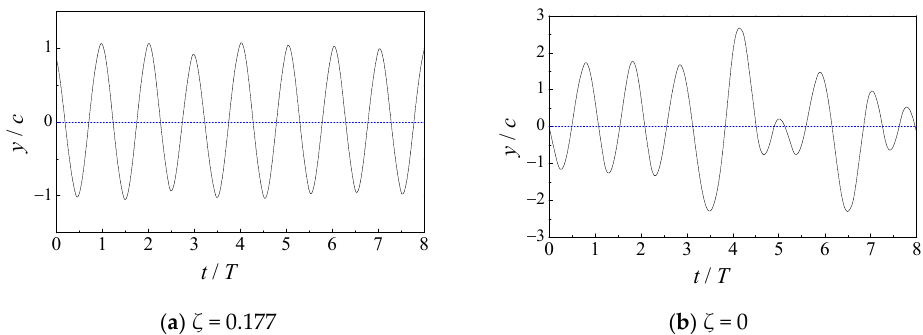
Figure 9. Heavy displacement time history curves with different damping ratios under baseline case conditions.: ( a ) ζ = 0.177; ( b ) ζ = 0.